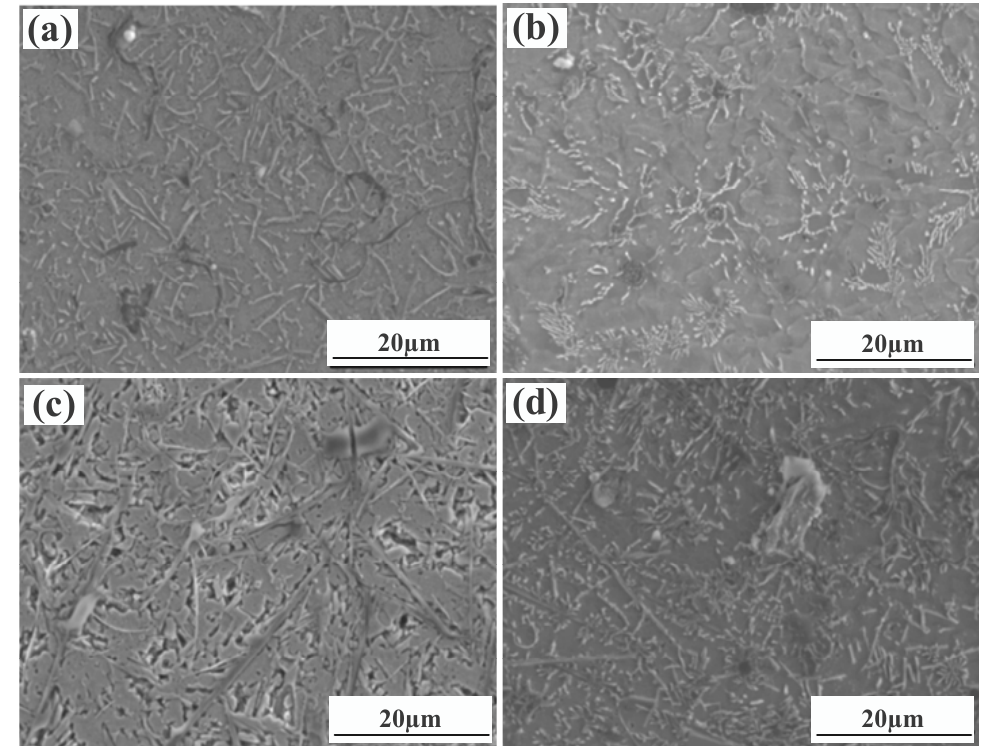
Figure 4. Microstructure of laser cladding Ni25—10%SiC—X% graphene cladding layers: ( a ) speci- men 1 (0% graphene content); ( b ) specimen 2 (0.5% graphene content); ( c ) specimen 3 (1% graphene content); ( d ) specimen 4 (1.5% graphene content).